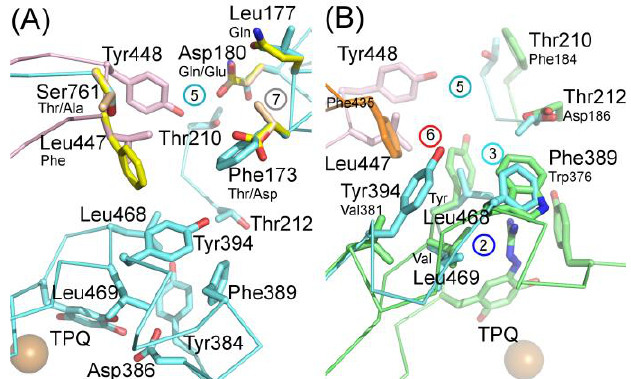
Figure 7. ( A ) Species-specific residues in the VAP-1 active site channel. Residues in rat (wheat) / mouse (yellow) VAP-1 are listed below the residue labels of hVAP-1 (cyan / pink). The catalytic center around TPQ is totally conserved, and the residue di ff erences concentrate on the Arm I and the first helix of D3; ( B ) key residue di ff erences between hVAP-1 and hDAO (green / orange). The Aminoguanidine–hDAO complex (green; PDB code 3MPH) superimposed with hVAP-1 structure (PDB code 2C10). Binding sites depicted similarly as in Figure 3.